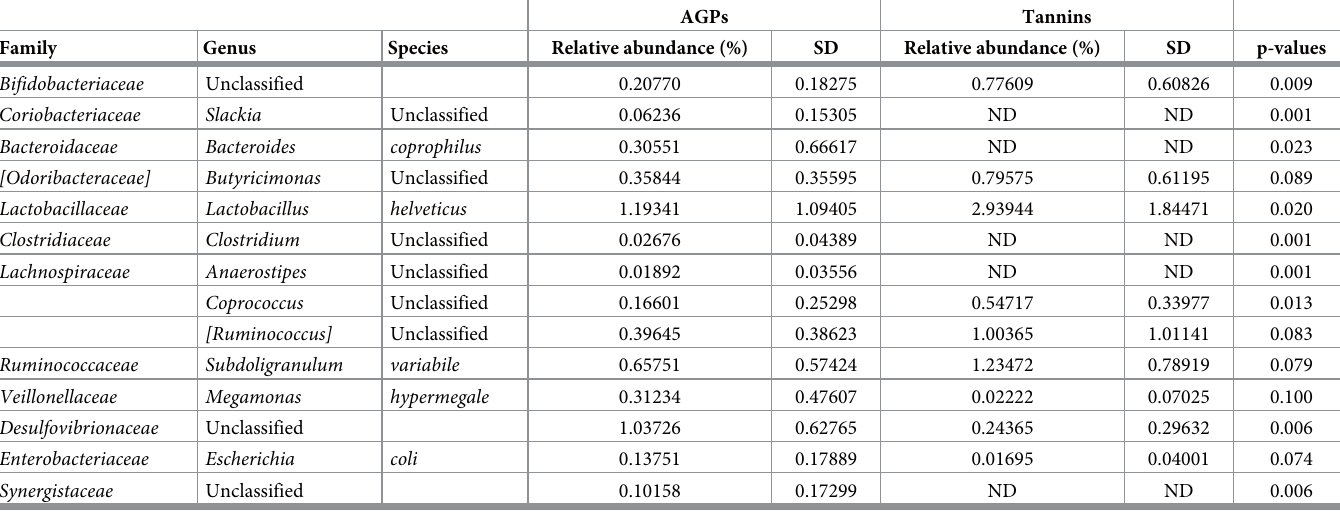
Table 7. Cecal microbiota composition, AGPs vs. tannins (Experiment 2).